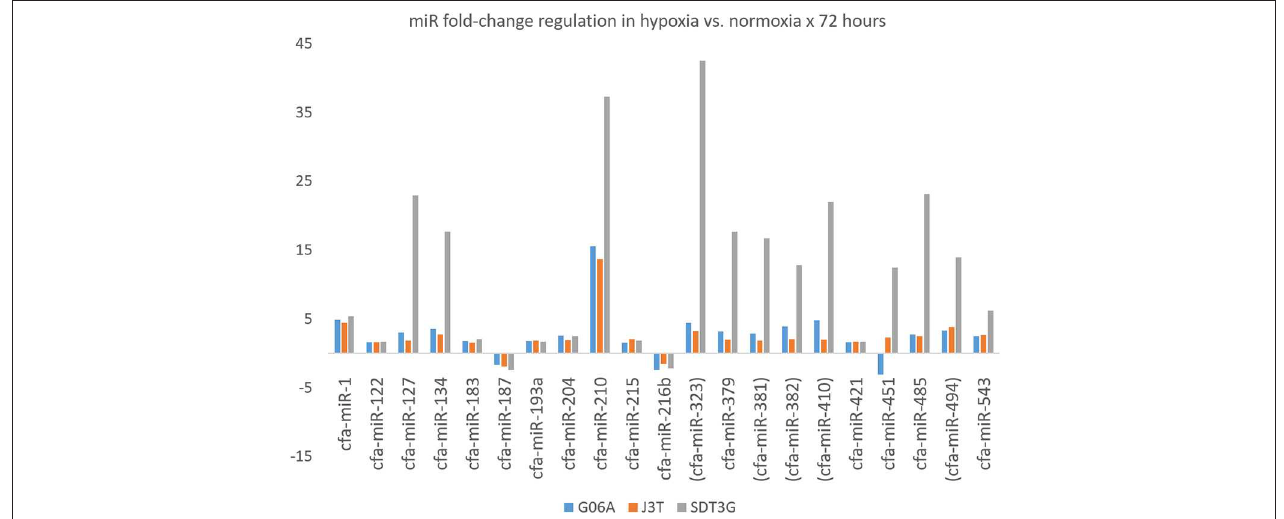
FIGURE 4 | Fold-change regulation for miRNAs differentially regulated in all three cell lines. Parentheses indicate members of the miR-154